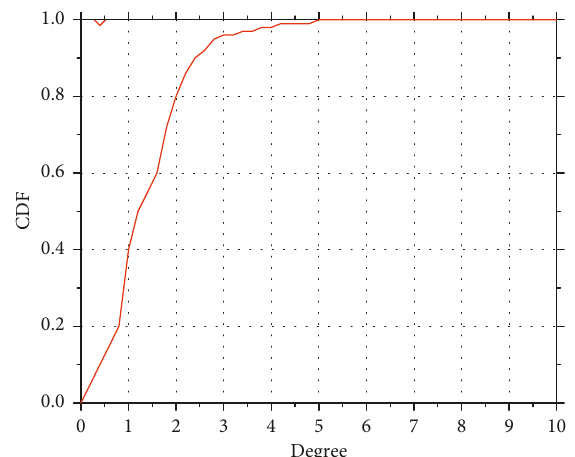
Figure 2: Cumulative distribution function of node